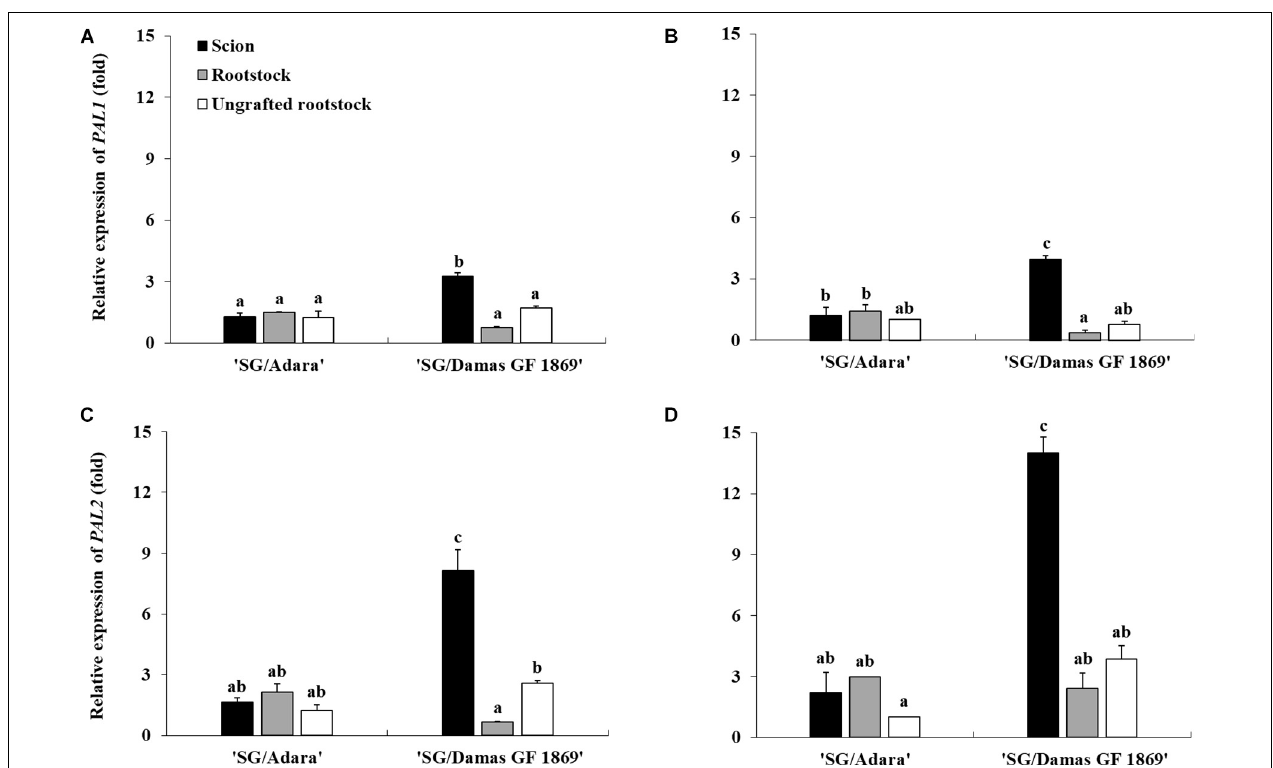
FIGURE 4 | Differential expression of PAL1 and PAL2 genes in the bark from the scion and rootstock of the compatible (“SG/Adara”) and incompatible (“SG/Damas GF 1869”) graft-combinations, and ungrafted rootstocks [ (A,C) October 2017; (B,D) June 2018] 3 years after grafting. Vertical bars represent the mean ± SE ( n = 3 replicates). For each graph, abc Mean values are significantly different at the P ≤ 0.05 level according to Duncan’s Multiple Range Test.